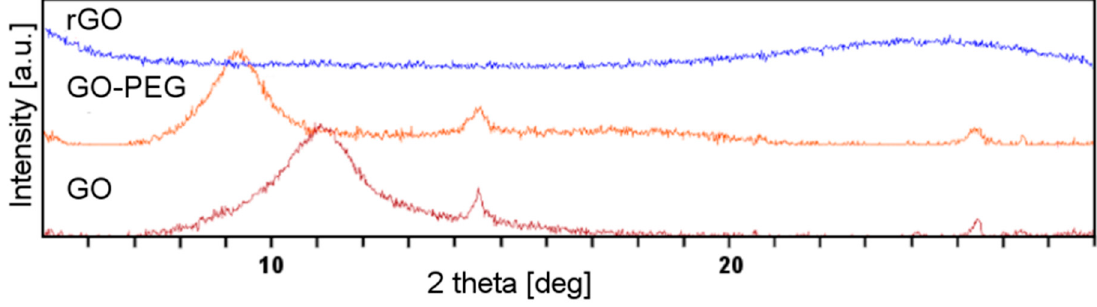
Figure 2. X-ray diffractometry (XRD) patterns of graphene oxide (GO), poly(ethylene glycol) grafted graphene oxide (GO-PEG) and reduced graphene oxide (rGO).